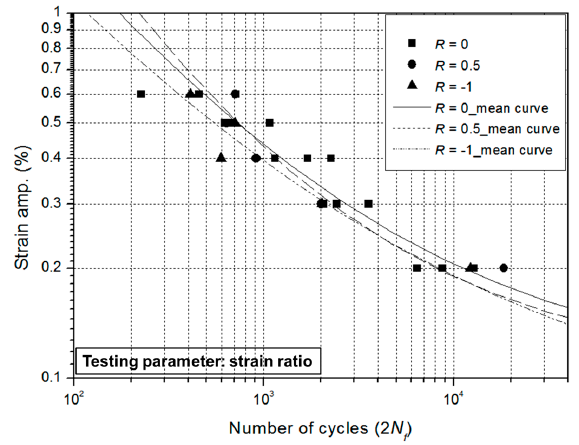
Figure 9. Strain–life curves for thickness of 10 mm under three different strain ratios.